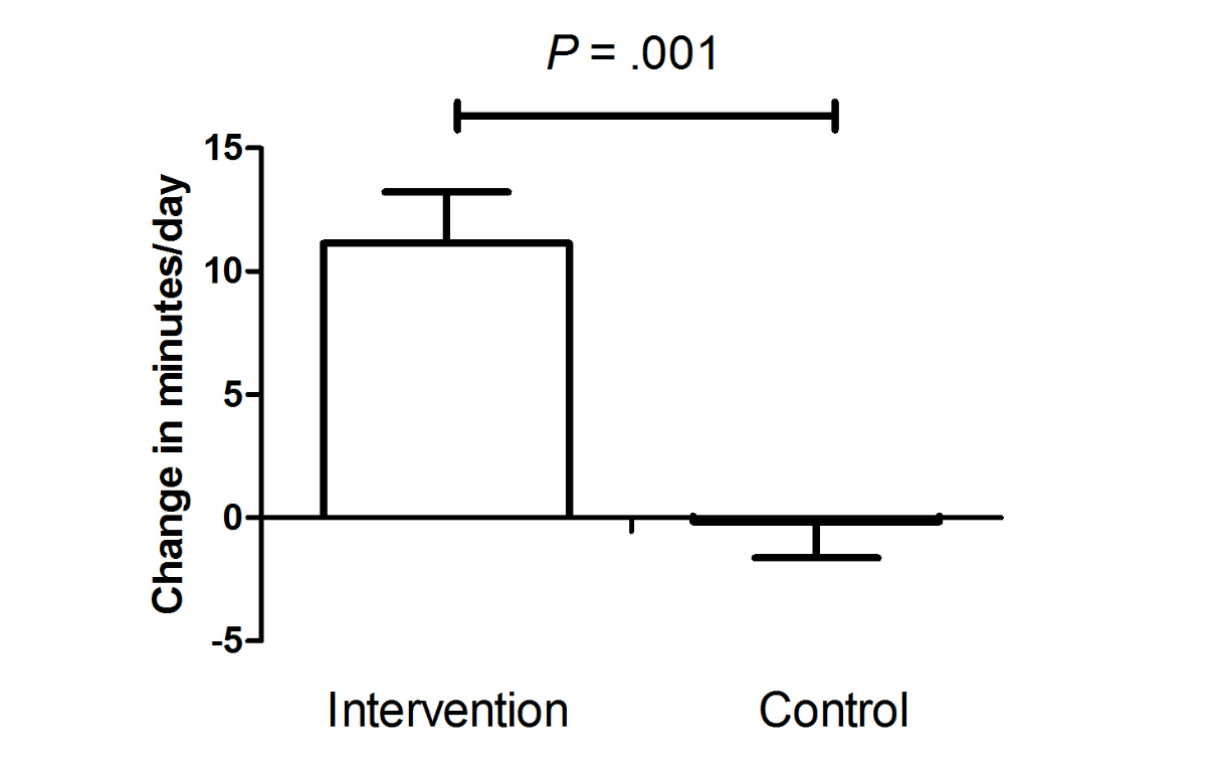
Figure 2. Change in daily physical activity expressed as moderate-to-vigorous physical activity measured at the wrist.